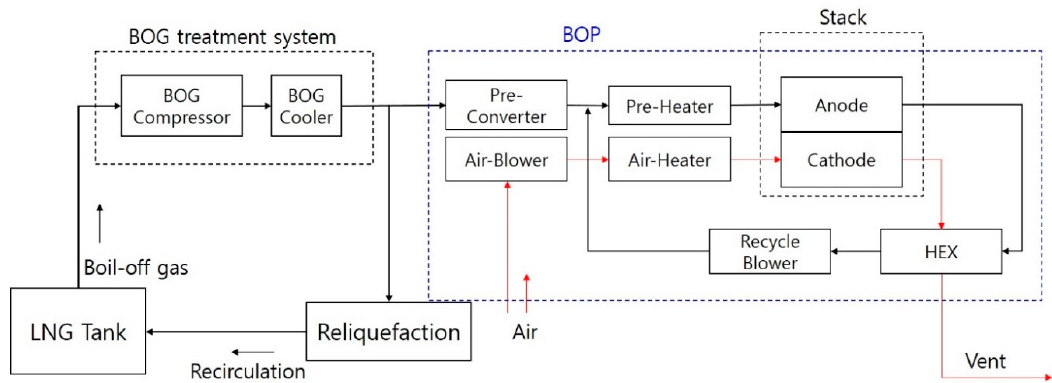
Figure 1. Scheme of boil-o ff gas (BOG) treatment system with fuel cell system for a liquefied natural gas (LNG)-fueled ship.